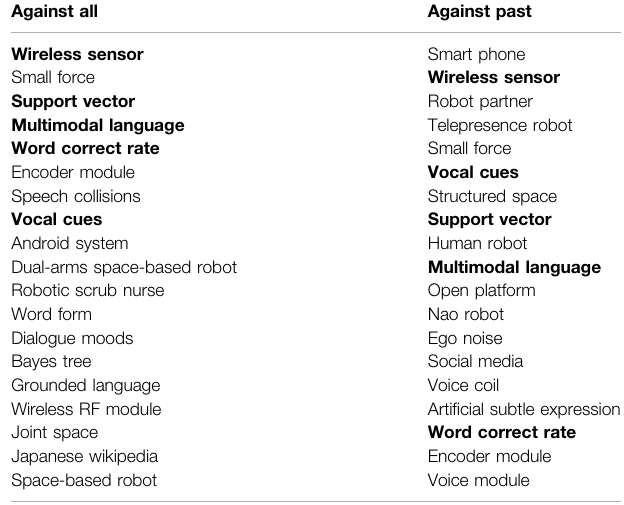
TABLE 1 | Contrastive analysis: range 2000 – 2004. Against all